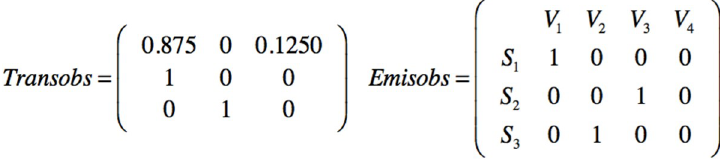
Figure 27. Posterior transition and emission matrices obtained from the observed sequence.